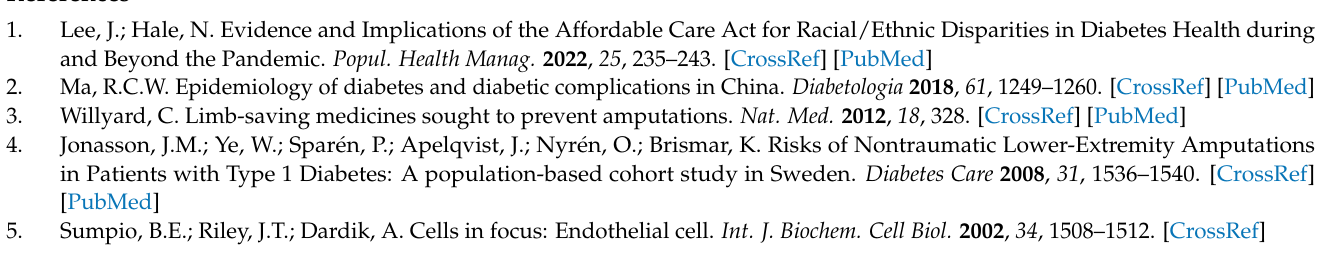
Figure S2: The efficiency of manipulating the DNMT1, miR-126-3p, and CSE expression in endothelial cells; Table S1: Sequences for the reverse and real-time PCR primers; Table S2: Blood glucose with or without STZ treatment; Table S3: Body weight with or without STZ treatment; Excel S1: miRNAs expression in plasma between healthy controls and diabetes